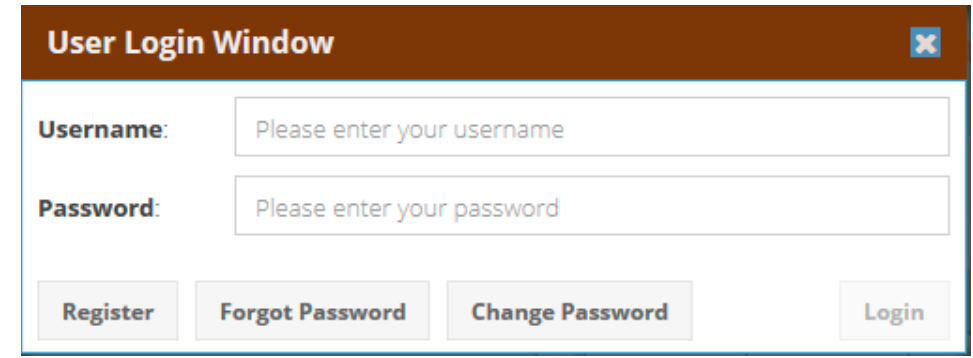
Figure 6. User rights administration.